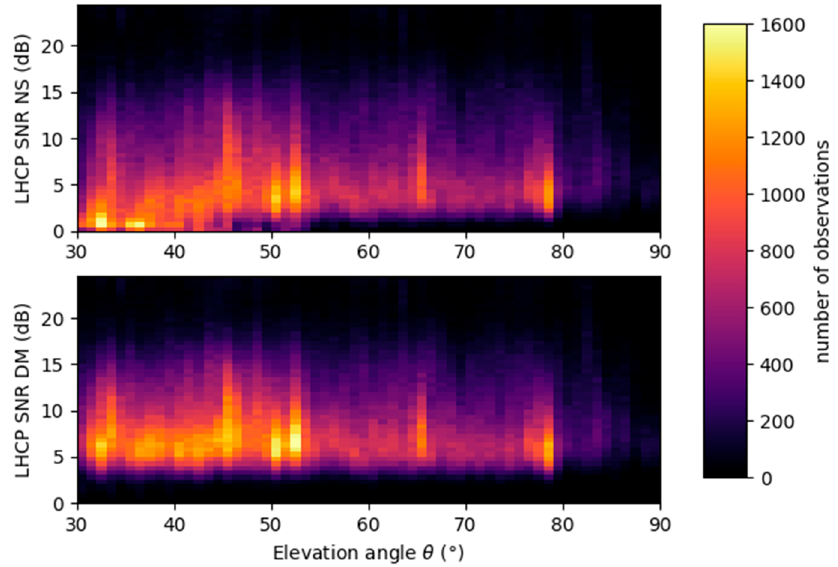
Figure 15. Data availability vs SNR and elevation angle for original dataset ( top ) and reprocessed dataset ( bottom ).